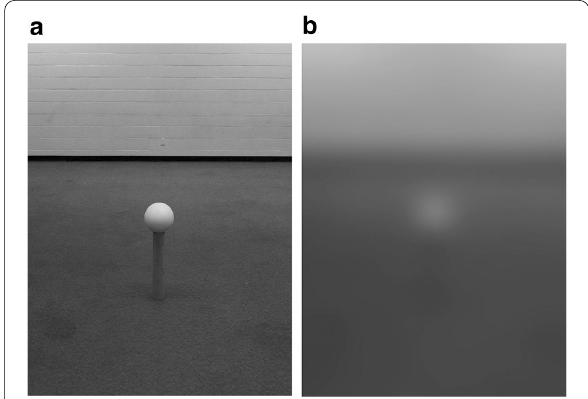
Fig. 8 The gray stand is detectable with normal viewing ( a ), but undetectable under degraded vision ( b ). Viewing with blur goggles led to overestimation of distance and size of the target. Adapted from Rand et al. (2012) with permission from